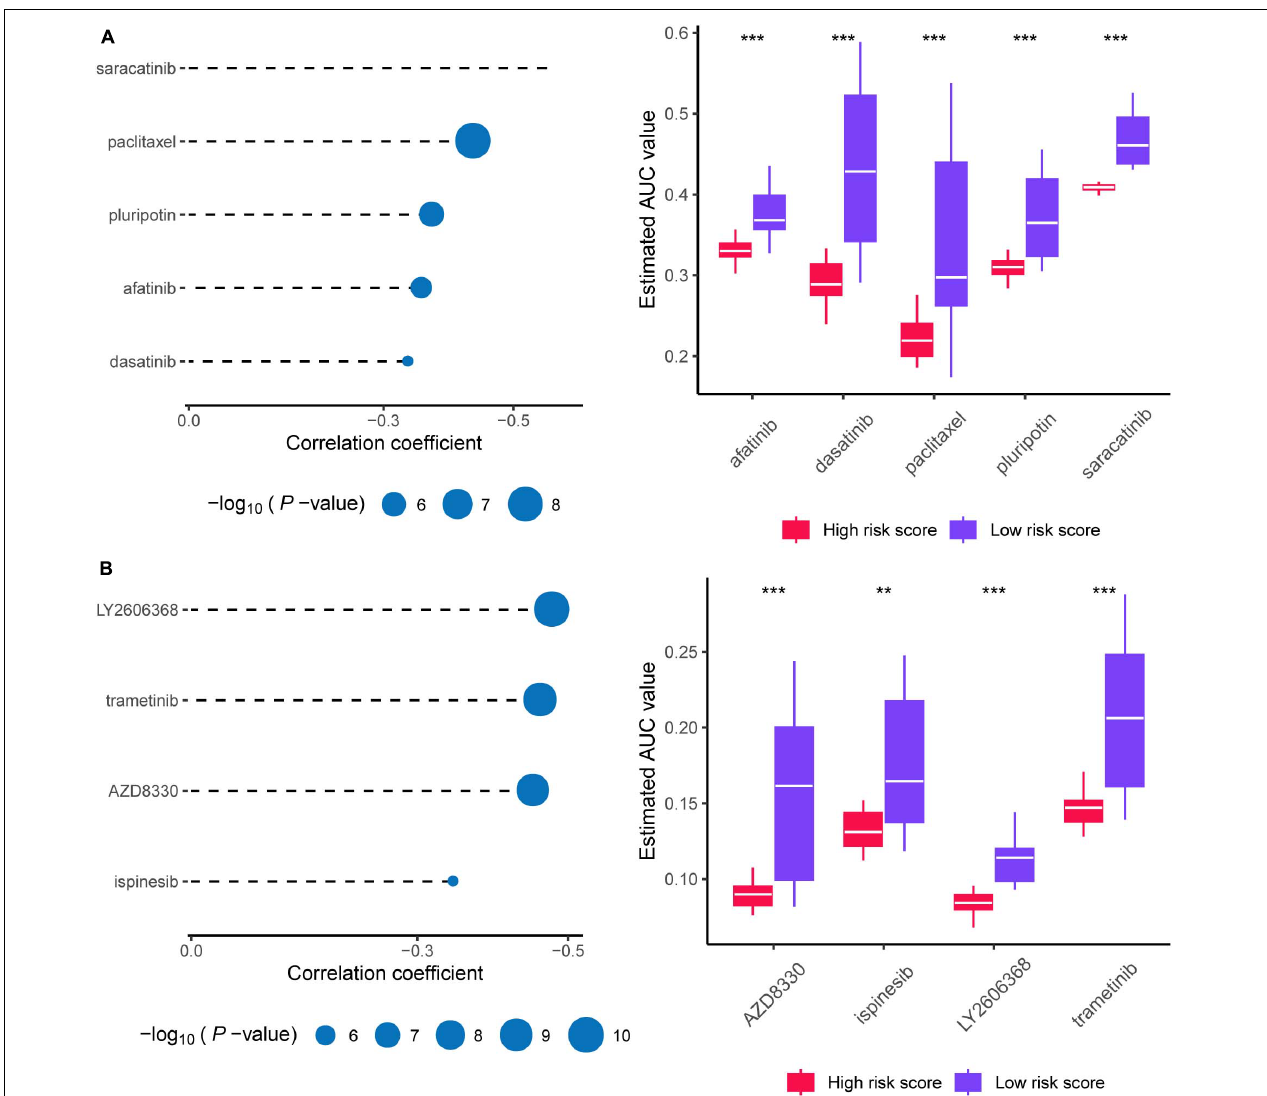
FIGURE 10 | Prediction of candidate agents with higher drug sensitivity in patients with high risk score. (A) The results of Spearman’s correlation analysis and differential drug response analysis of three CTRP-derived compounds. (B) The results of Spearman’s correlation analysis and differential drug response analysis of three PRISM-derived compounds. Note that lower values on the y-axis of boxplots imply greater drug sensitivity. * means P < 0.05, ** means P < 0.01, *** means P < 0.001, ns means P > 0.05, and P < 0.05 is defined as statistically significant.